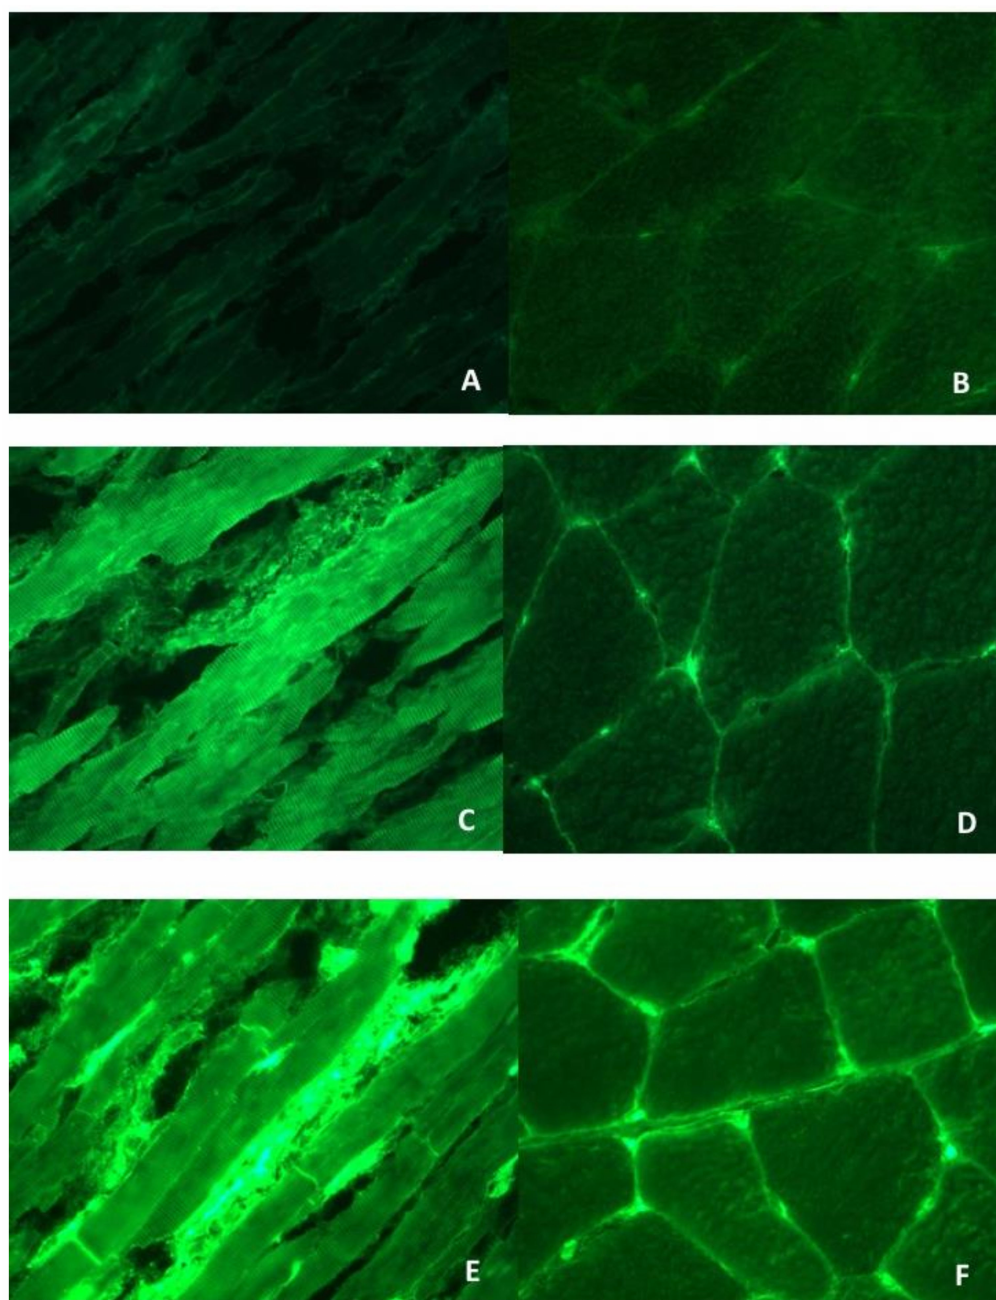
Figure 1. Anti-heart autoantibody (AHA) and anti-intercalated disk autoantibody (AIDA) patterns by indirect immunoflu- orescence test. Negative AHA and AIDA control serum pattern ( A ) on human heart tissue (negative ( × 400)) and ( B ) on human skeletal muscle (negative ( × 200)). Organ-specific AHA pattern ( C ) on human heart tissue (strong cytoplasmic and striational staining of cardiac myocytes (organ-specific AHA pattern) ( × 400)) and ( D ) on human skeletal muscle tissue (negative ( × 200)). Organ-specific AHA and AIDA pattern: ( E ) strong linear staining of the intercalated disks (AIDA pattern) and associated weak organ-specific AHA pattern ( × 400) and ( F ) on human skeletal muscle tissue (negative ( ×